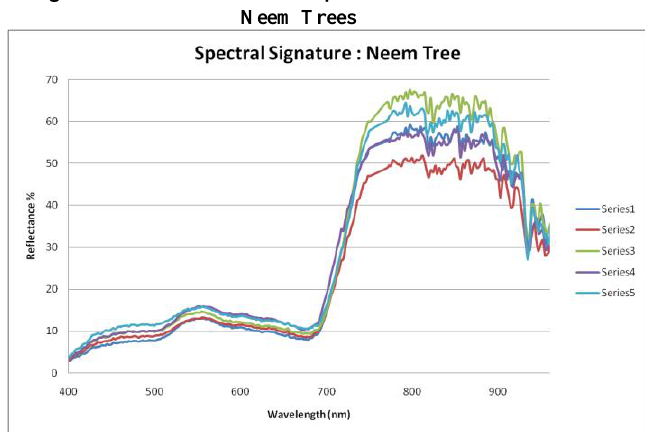
Fig. 13. Spectral Signature of Neem Trees